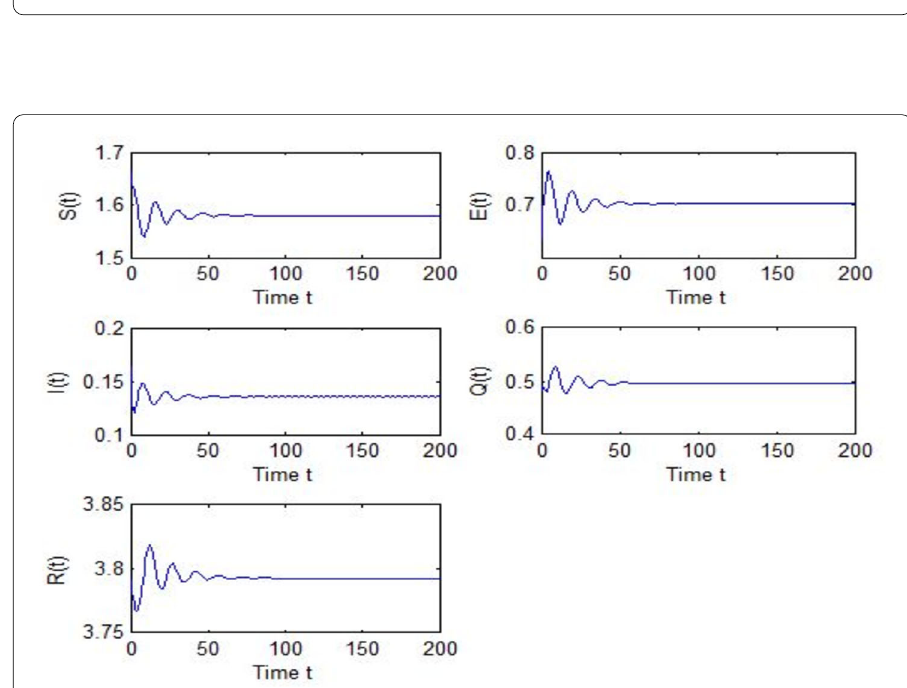
Figure 7 Evolutions of S , E , I , Q , R for τ 1 = 2.5966 < τ 10 , τ 2 = 2.299 along with time t